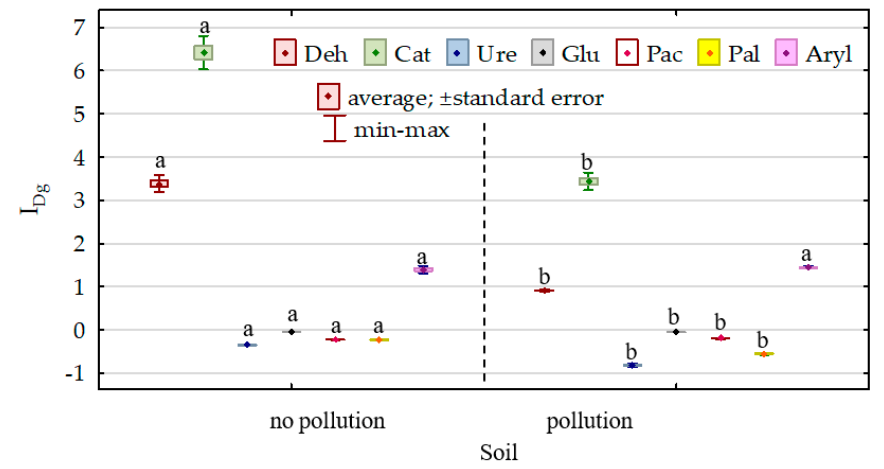
Figure 9. Index of the effect of Dactylis glomerata (I Dg ) on soil enzyme activity. Homogeneous groups denoted with letters (a–b) were calculated separately for each enzyme.